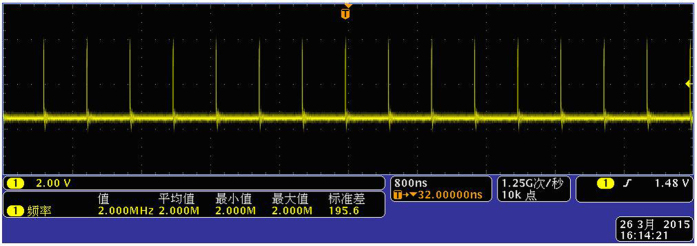
Phase coincidences between f1 and f2.